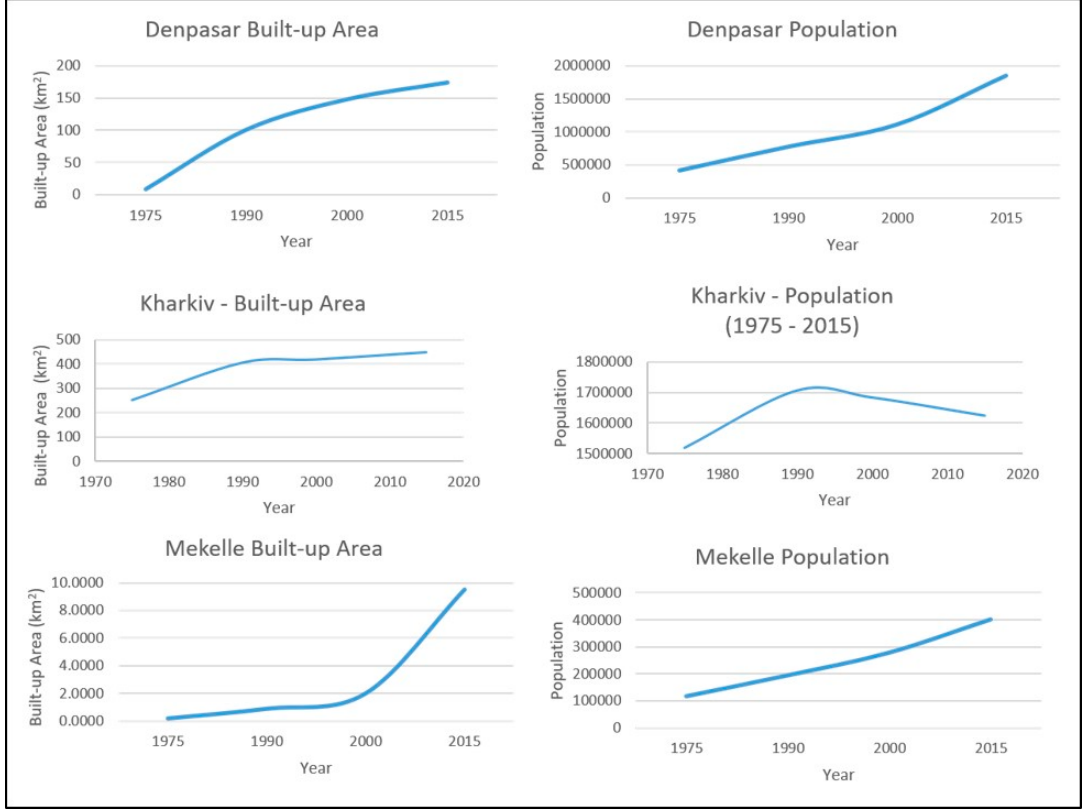
Table 2. Built-up areas and population for Denpasar, Indonesia, Kharkiv, Ukraine, and Mekelle, Ethiopia. City